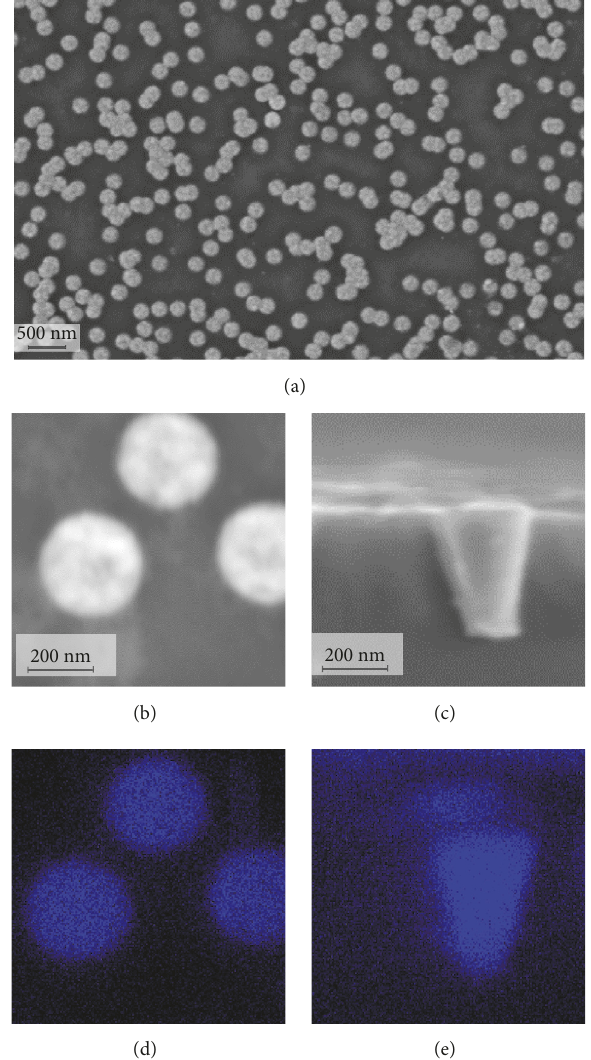
Figure 1: SEM images SiO 2 (Ni)/Si nanosystems: surface (a, b), cross sections, (c) and EDS mapping images (d, e) of regions (b, c).